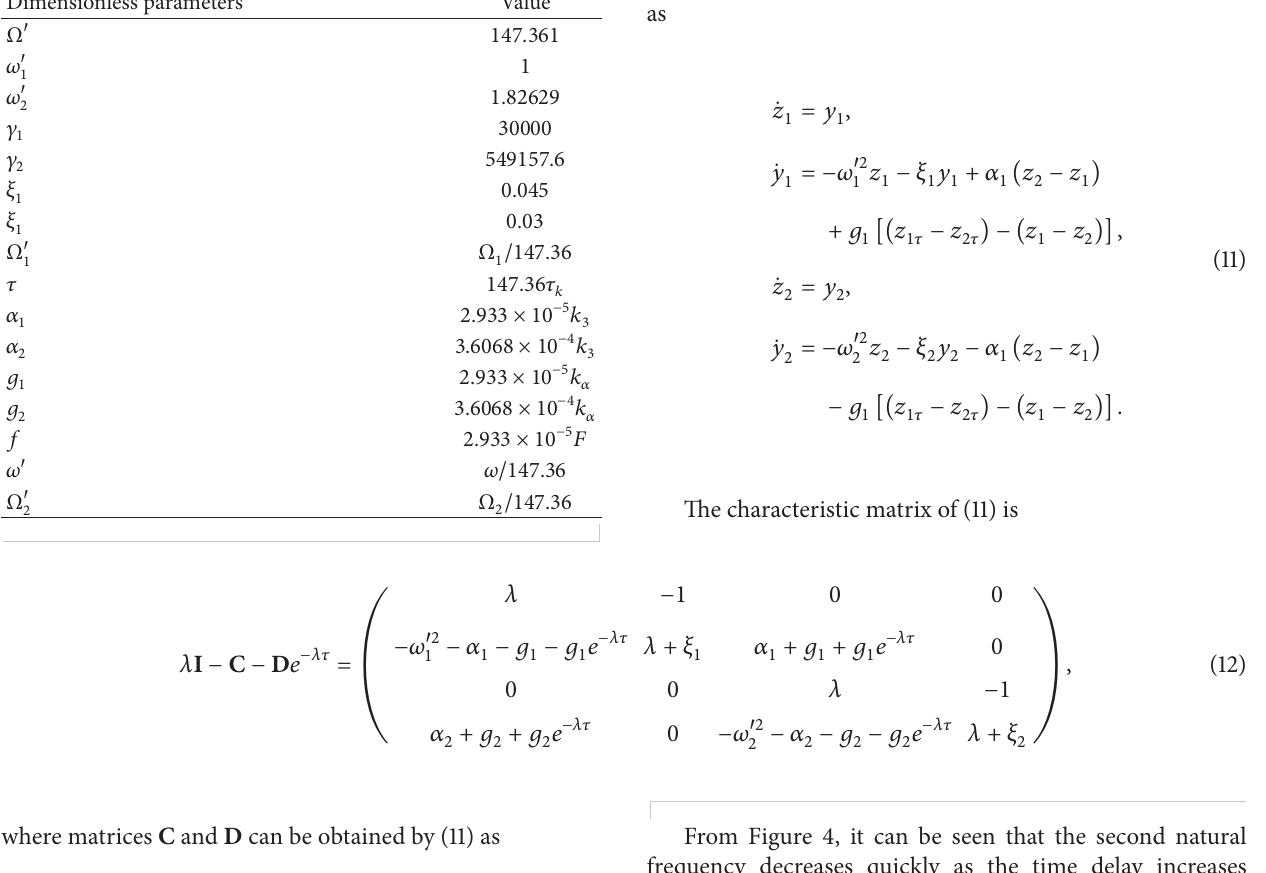
Table 2: The value of dimensionless parameters. Dimensionless